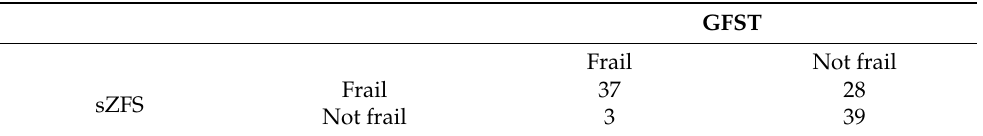
Table 6. Contingency table–Zulfiqar frailty scale vs. GFST’s criteria, with “pre-frail” and “robust” patients making up the “non-frail”